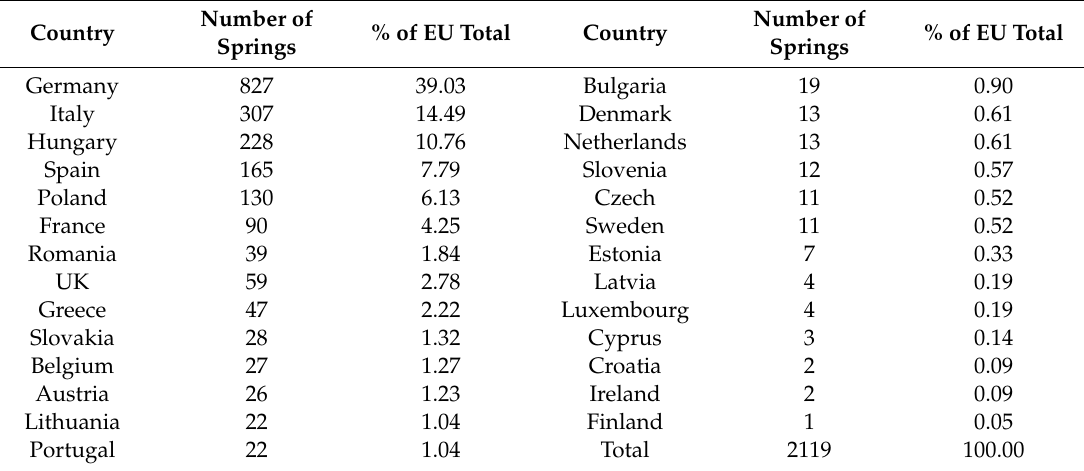
Table 4. Water bottling plants in other countries of the European Union for the year 2019. Source: European Commission, List of Mineral Waters Recognized by Member States (consultation on 8 February 2019). Number of Number Country % of EU Total Springs